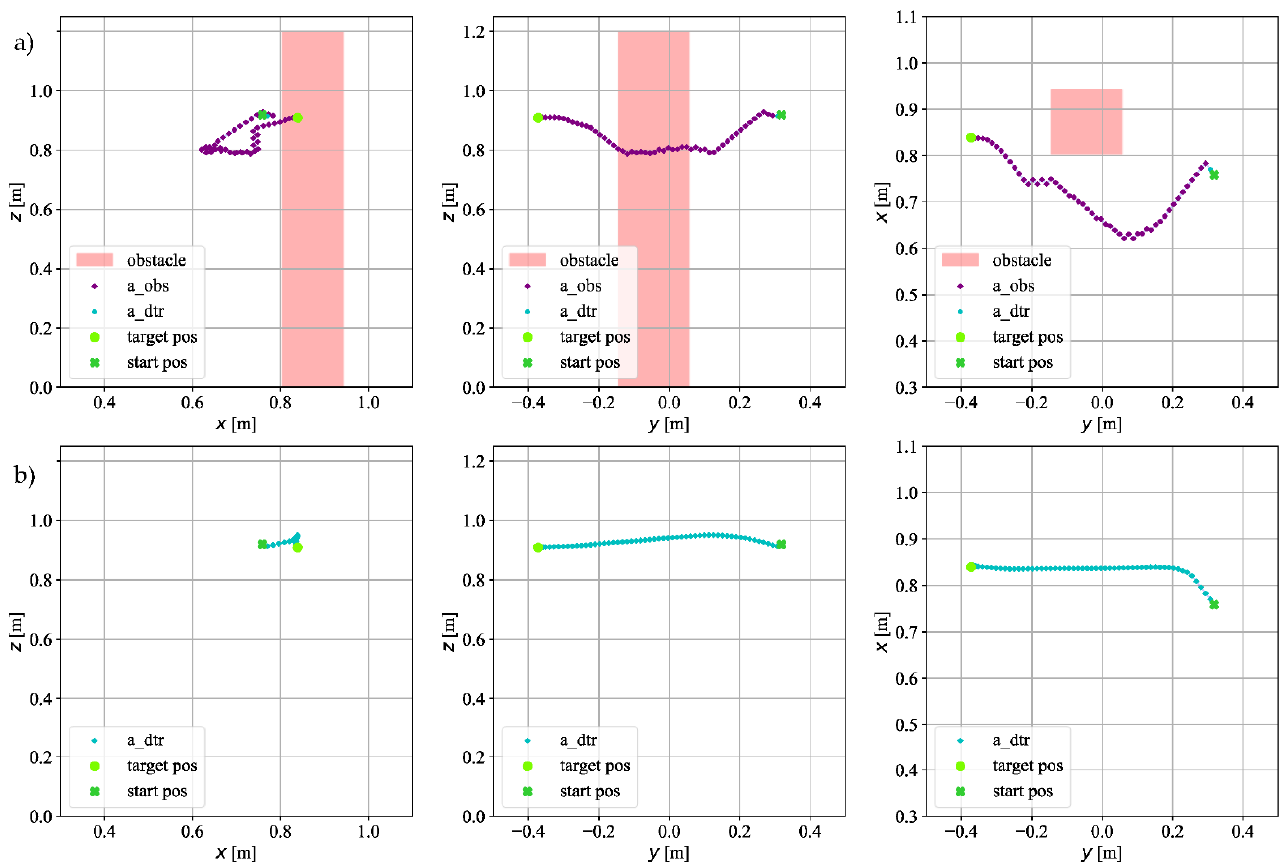
Figure 9. The trajectory on which the TCP of the robot moved in simulation for goal point 𝑔 2 : ( a ) with an obstacle; ( b ) without an obstacle.